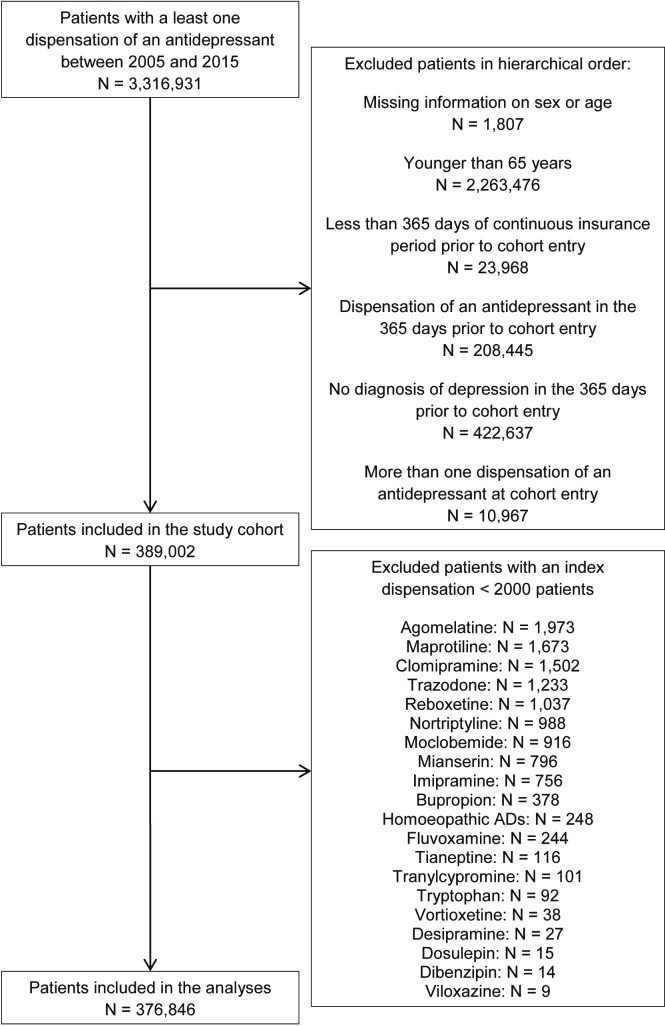
Flow chart of in- and exclusion criteria.